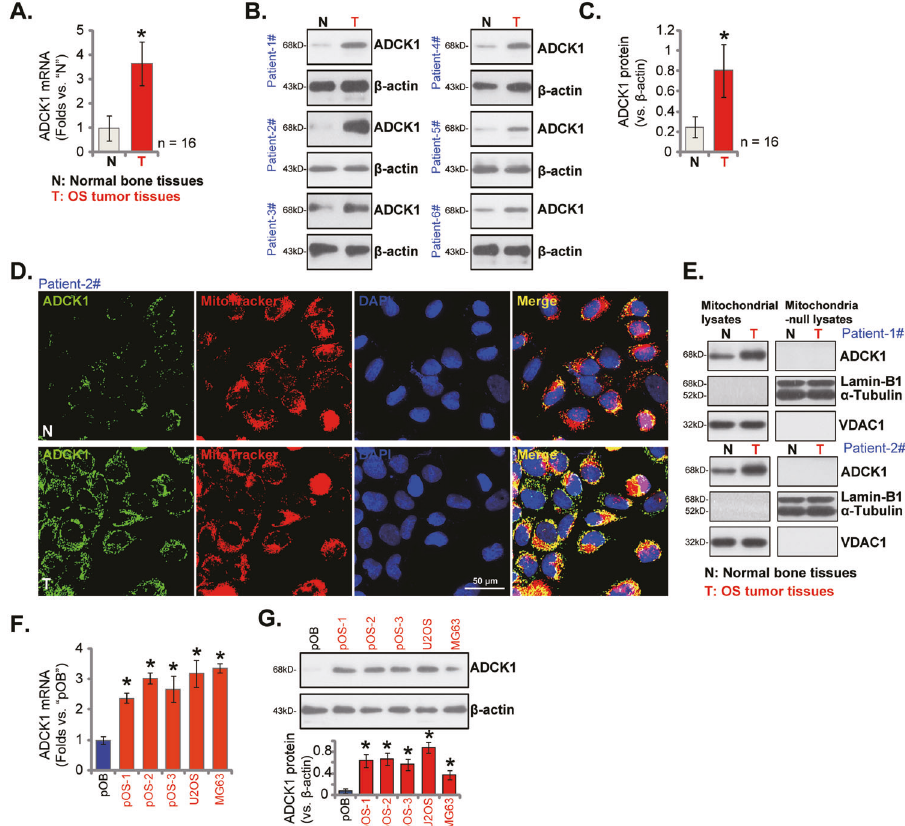
Fig. 1 ADCK1 expression is elevated in OS. ADCK1 mRNA and protein expression in OS tumor tissues ( “ T ” ) and matched adjacent normal bone tissues ( “ N ” ) from a total of 16 different primary OS patients ( n = 16) was tested by qRT-PCR and Western blotting assays, and results quanti fi ed ( A – C ). The representative fl uorescence images of ADCK1 protein (in green fl uorescence), the MitoTracker Red (staining mitochondria, in red fl uorescence) and DAPI (nuclei, in blue fl uorescence) in the OS tumor slide ( “ T ” ) and the adjacent normal bone tissue slide ( “ N ” ) of Patient-2# were shown ( D ). Expression of the listed proteins in the mitochondrial lysates and the mitochondria-null lysates of tissues from two representative OS patients (Patient 1# and Patient 2#) was shown ( E ). ADCK1 mRNA and protein expression in primary OS cells (pOS-1, pOS-2 and pOS-3), established OS cell lines (U2OS and MG63) and primary human osteoblasts ( “ pOB ” ) were tested ( F , G ). Data were presented as mean ± standard deviation (SD). * P < 0.05 vs. “ N ” tissues or “ pOB ” cells. Scale bar = 50 μ m ( D